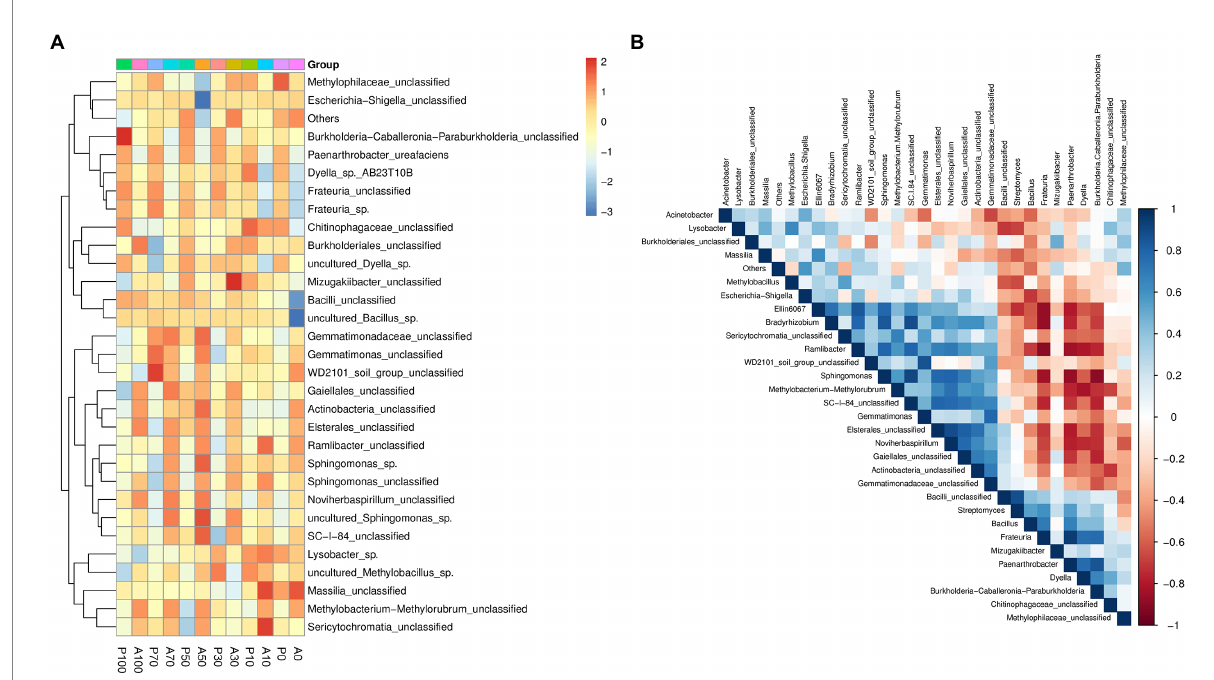
FIGURE 7 Heatmaps showing relative abundances of abundant genera (A) ; Spearman rank correlation obtained by the analysis of top 30 genera in different treatments at 7 days (B) ; Network A0: Equivalent amount of methanol were added into native soil. A10: 10 mg kg − 1 atrazine-contaminated soil; A30: 30 mg kg − 1 atrazine-contaminated soil; A50: 50 mg kg − 1 atrazine-contaminated soil; A70: 70 mg kg − 1 atrazine-contaminated soil; A100: 100 mg kg − 1 atrazine-contaminated soil; P0: Equivalent amount of methanol and P. ureafaciens ZY were added into native soil; P10: 10 mg kg − 1 atrazine- contaminated soil with P. ureafaciens ZY inoculation; P30: 30 mg kg − 1 atrazine-contaminated soil with P. ureafaciens ZY inoculation; P50: 50 mg kg − 1 atrazine-contaminated soil with P. ureafaciens ZY inoculation; P70: 70 mg kg − 1 atrazine-contaminated soil with P. ureafaciens ZY inoculation; P100: 100 mg kg − 1 atrazine-contaminated soil with P. ureafaciens ZY